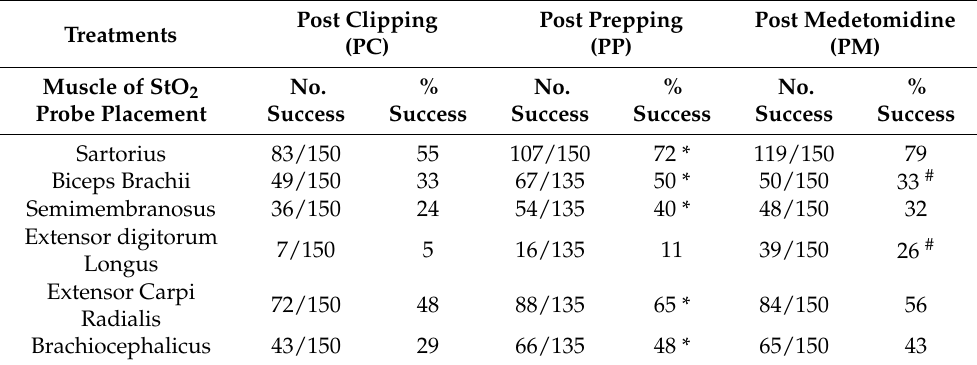
Table 2. Total number of successful readings and percentage number of successful readings for 50 horses following three